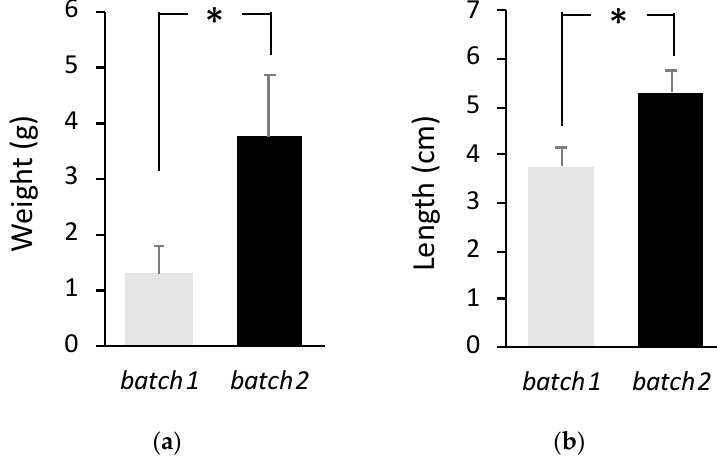
Figure 1. Weight ( a ) and length ( b ) for batch 1 and batch 2. The mean ± standard deviation is indicated (total n = 498 for each batch). Asterisk denotes significant differences between batches.